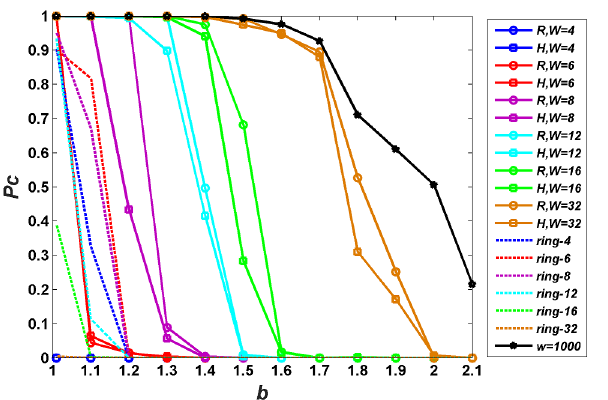
Fig 3. Density of cooperators P C on scale-free networks as a function of defection temptation b for different upper-bounds W under a standard PDG parameter combination R = 1, P = 0, S = − 0.1,2.1 > b > 1. Populationsize is set as N = 1000. R and H correspondto random interaction and high-degree interaction, respectively.The result on corresponding regular ring- W networks is denotedby the dotted line with the same color.